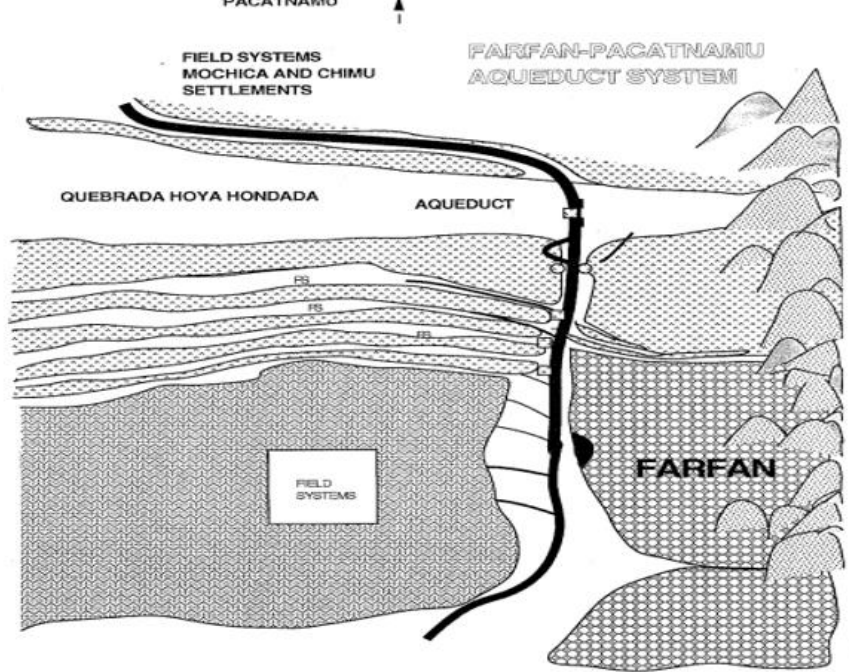
Figure 8. Details of the Farfan–Pacatnamu aqueduct system. Figure from [1], p.